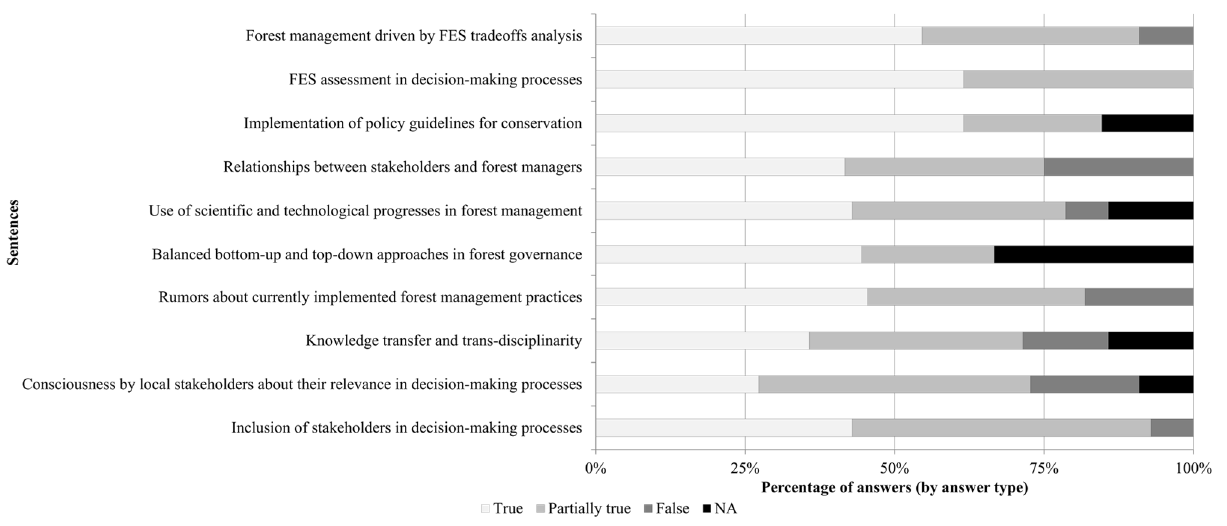
Figure 6. Bar chart showing the relative percentage of respondents to several